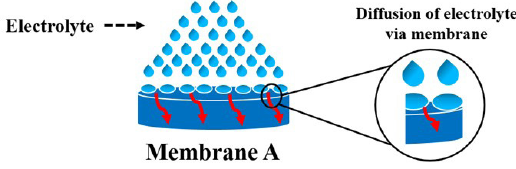
Figure 10. Schematic representation of the electrolyte permeation in membrane A